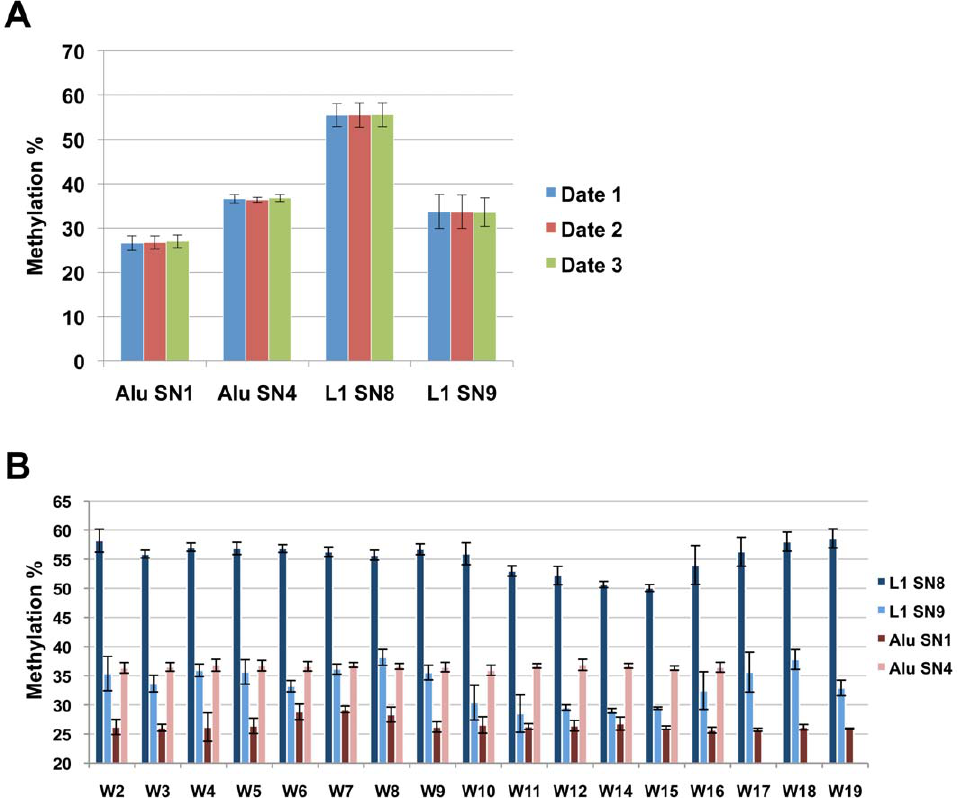
Figure 1. Average methylation levels at LINE-1 (SN9 and SN8) and Alus (SN1 and SN4) A) on three dates during the menstrual cycle (Date 1: during the menstruation phase, 55 samples; Date 2: near the ovulation phase, 56 samples; Date 3: during middle of secretory phase, 53 samples). The data are the averages of all participating women and all measurements. B) of all blood samples taken from a given female donor. The graph shows the inter-individual variability between donors that is persistent over 3–4 months period. The donor number is given on the horizontal axis.